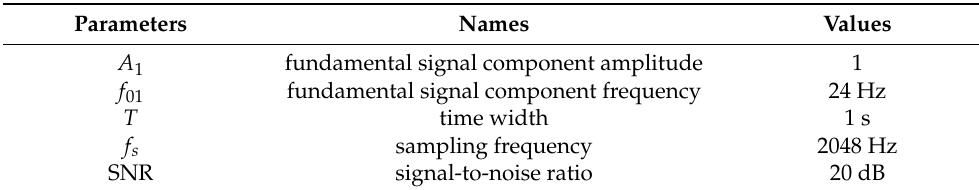
Table 5. Parameters of the rotor misalignment vibration fault